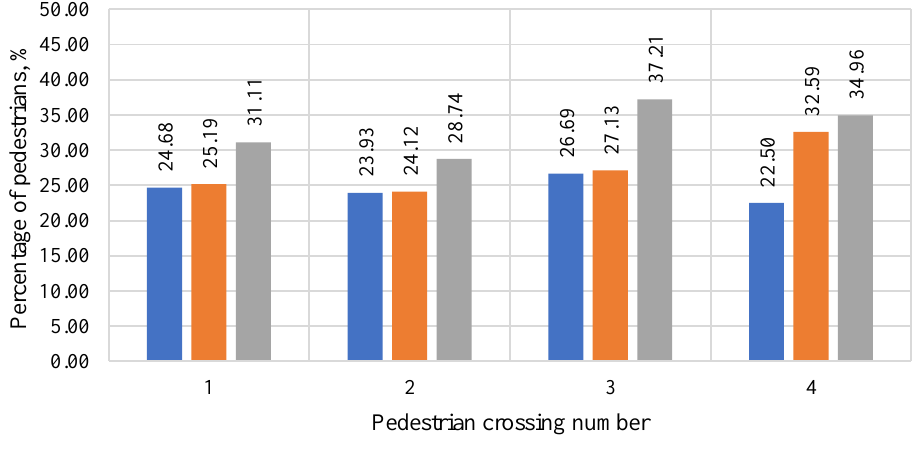
Figure 13. Percentage characteristics of people passing through the observed pedestrian crossing with a held-out mobile phone.